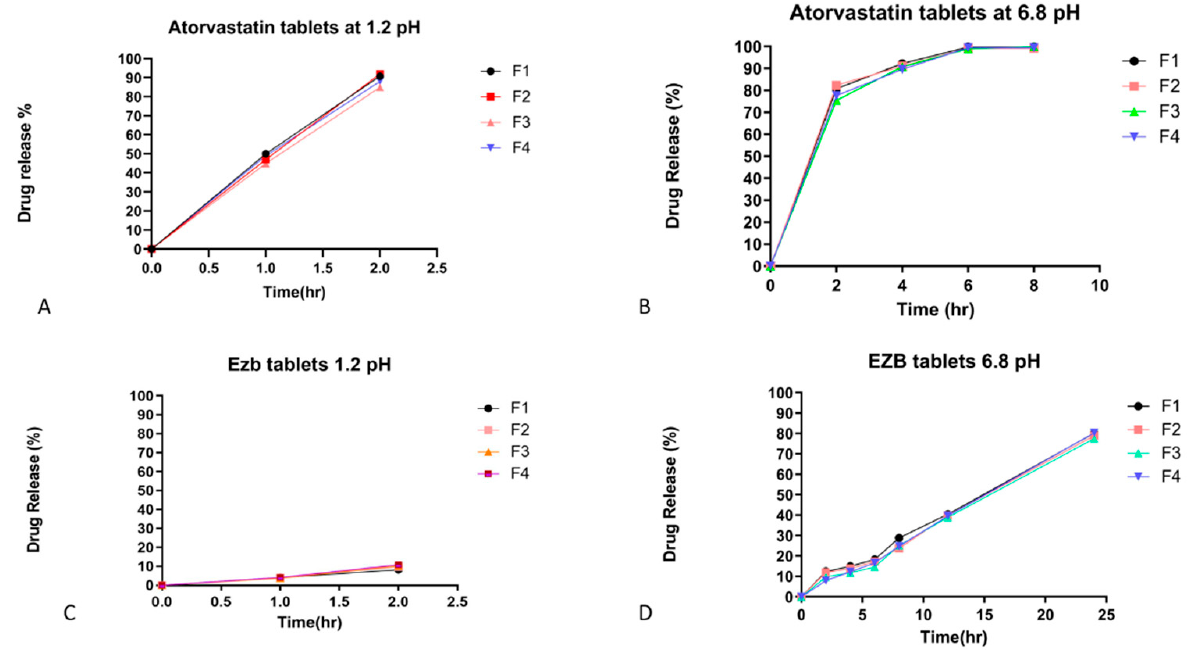
Figure 1. Drug release of bilayer coated (Eudragit L-100) tablets of ezetimibe and atorvastatin at pH 1.2 and pH 6.8. Atorvastatin release in stomach at pH 1.2 and at intestinal pH 6.8 ( A , B ), with slow release after 2 h stay. EZB release and stay in stomach at pH 1.2 is minimum and intestinal pH 6.8 showed rapid release and stay for 24 h ( C , D ).